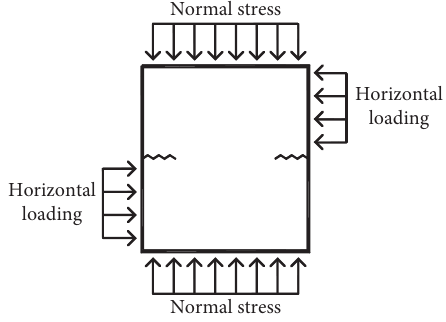
Figure 6: Test loading mode.